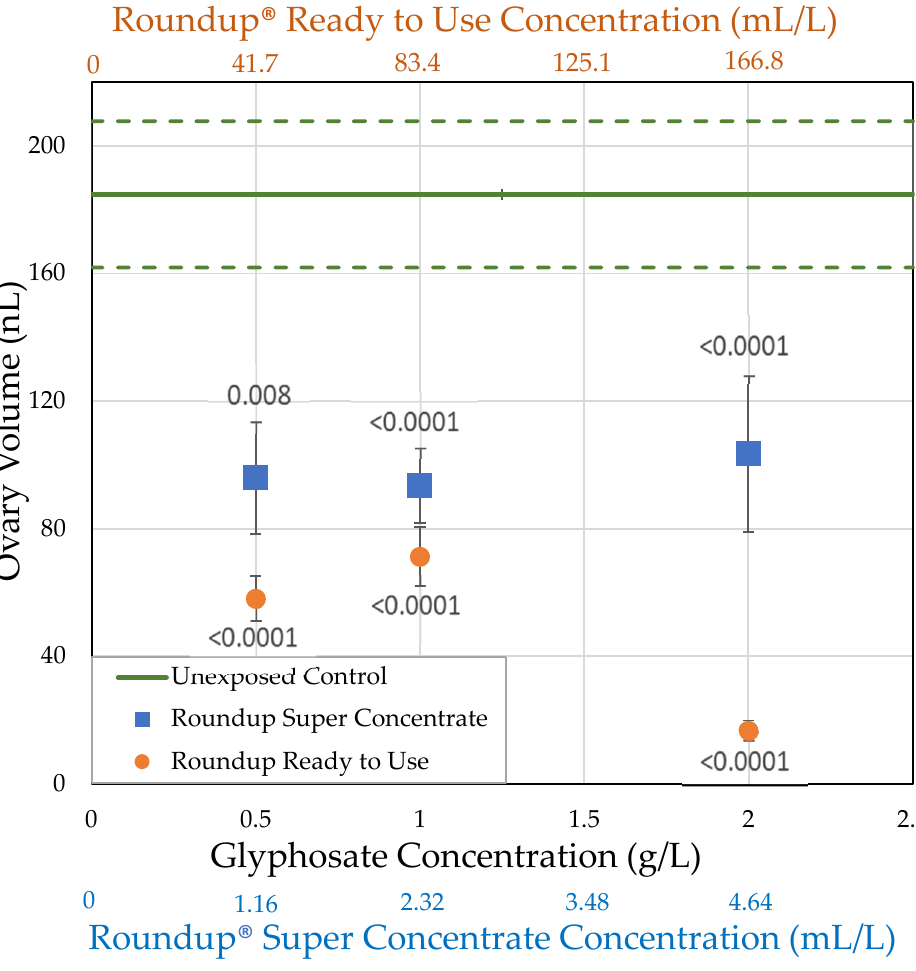
Figure 4. Ovary volume of D. melanogaster females exposed to herbicide in their food medium within 2 h of eclosion for 7 days, compared to the ovary volume of females exposed to the control medium (± std. error). The p -values shown are based on the t -tests in Table 2. Both Roundup ® formulations decreased the number of mature oocytes in female D. melanogaster exposed within 2 h of eclosion at all concentrations tested ( t -tests, Table 2; of mature oocytes in a non-dose-dependent manner, while pelargonic acid, total